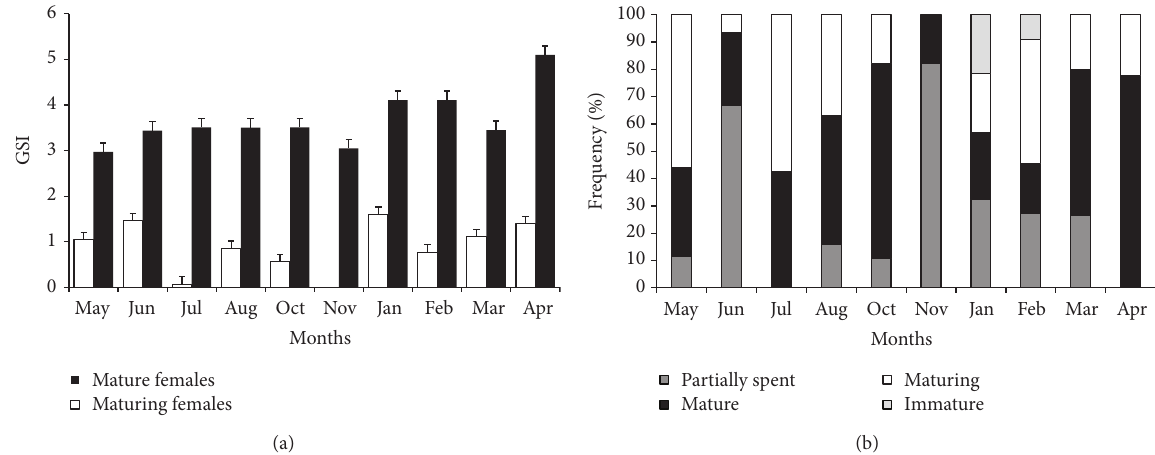
Figure 7: (a) Temporal dynamics of GSI ( ± SE) of H. brasiliensis maturing and mature females; (b) monthly frequency of maturity stages of the females of the H. brasiliensis ( 𝑁 females =